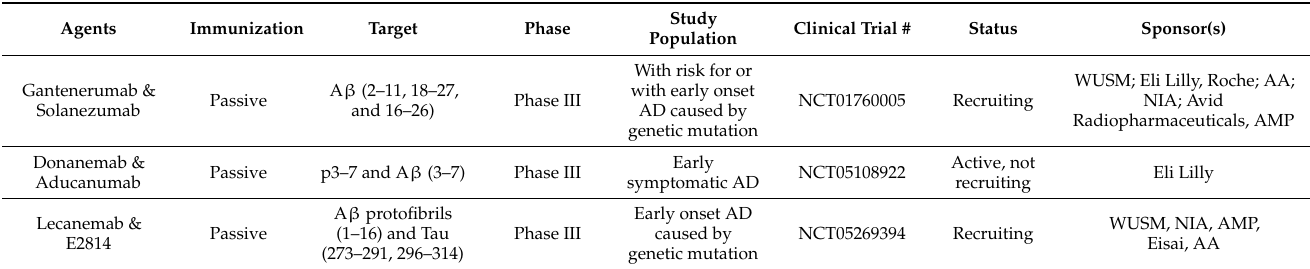
Table 3. Current ongoing clinical trials for the combination of A β and/or tau immunotherapy (Clinicaltrials.gov, as of 1 October